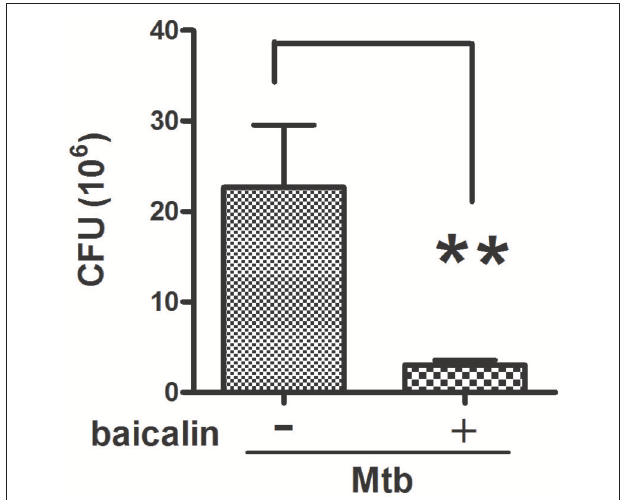
FIGURE 3 | Inhibitory effect of baicalin on bacillary loads. Bacterial CFUs were counted after baicalin treatment for 48h. ** p < 0.01, Data are shown as mean ± SD of three independent experiments.